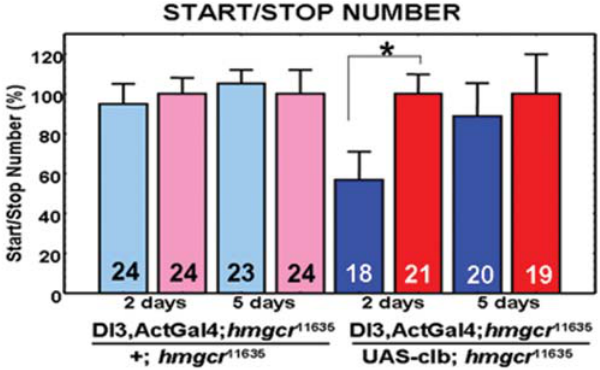
UAS- clb ; hmgcr 11635 ). This suggests a specific role for the HMGCR in the ca to control the sexual dimorphism. Interestingly, this rescue occurs in two days old flies, but not in the same flies of 5 days old.